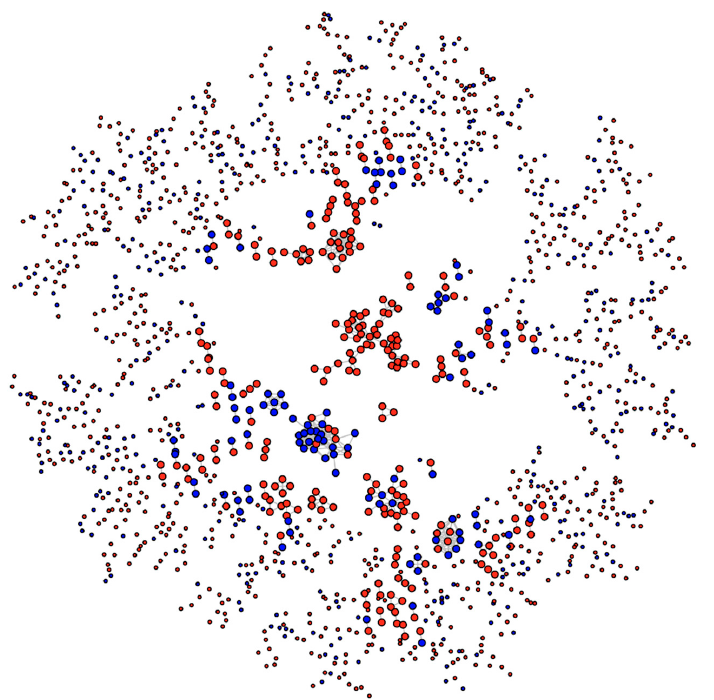
Figure 7. Network of human MetO-containing proteins. Two given proteins (nodes) are connected (linked by an edge) if they share at least 50% of their gene ontology terms. Nodes corresponding to proteins oxidized ex vivo are in red while those corresponding to proteins oxidized in vitro are in blue.